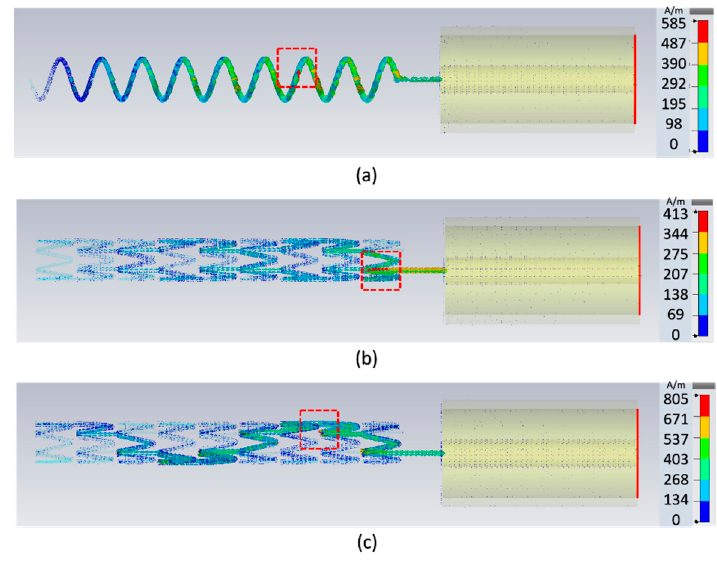
Figure 5. The simulated surface current distributions of the ( a ) helical stent, ( b ) multi-connector stent, and ( c ) single-connector stent antennas. At the resonant frequency, the multi-connector stent antenna has a radon current path where the helical and single-connector stent antennas have half-wavelength resonant modes. The red dashed box indicates the locations of the maximum current.